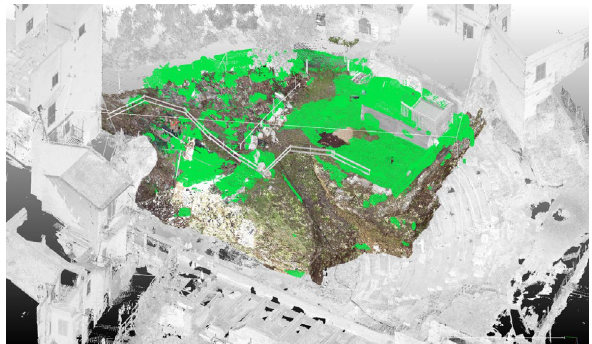
Figure 5: Mesh to Mesh volume